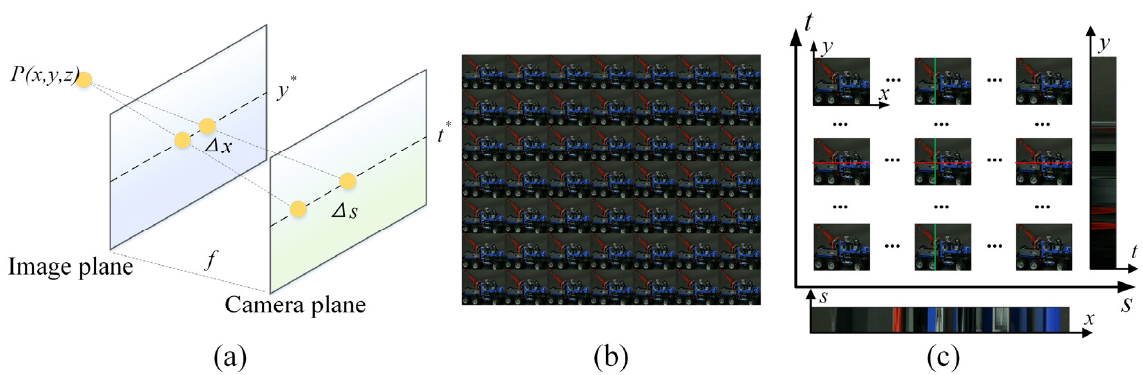
Figure 1. Light field imaging. ( a ) Light field EPI principle; ( b ) Multi-view images; ( c ) Epipolar plane image.